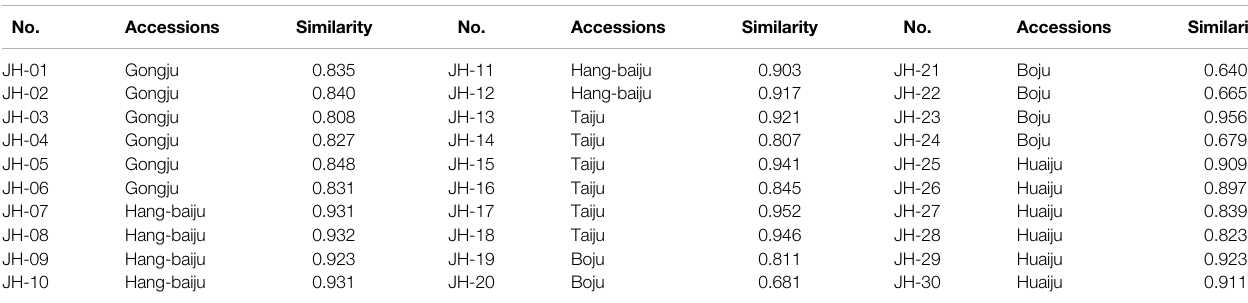
TABLE 2 | Similarity evaluation of different fl ower head samples of chrysanthemum samples. No. Similarity No. Accessions Similarity No.